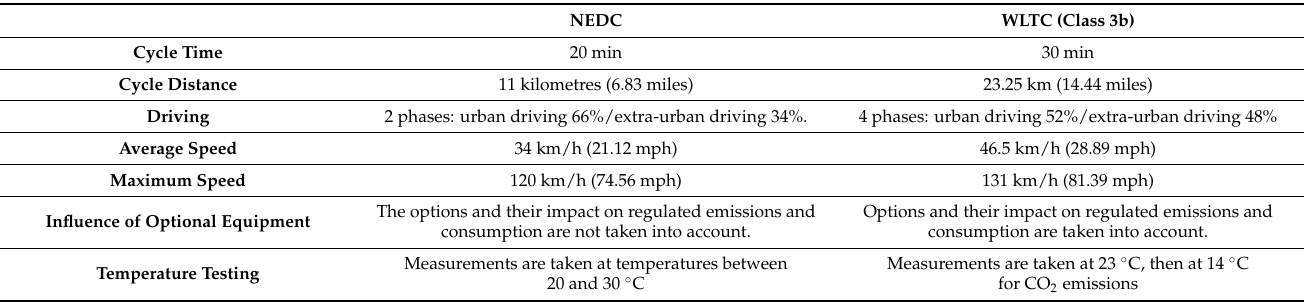
Table 3. Comparison of NEDC with WLTC (Class